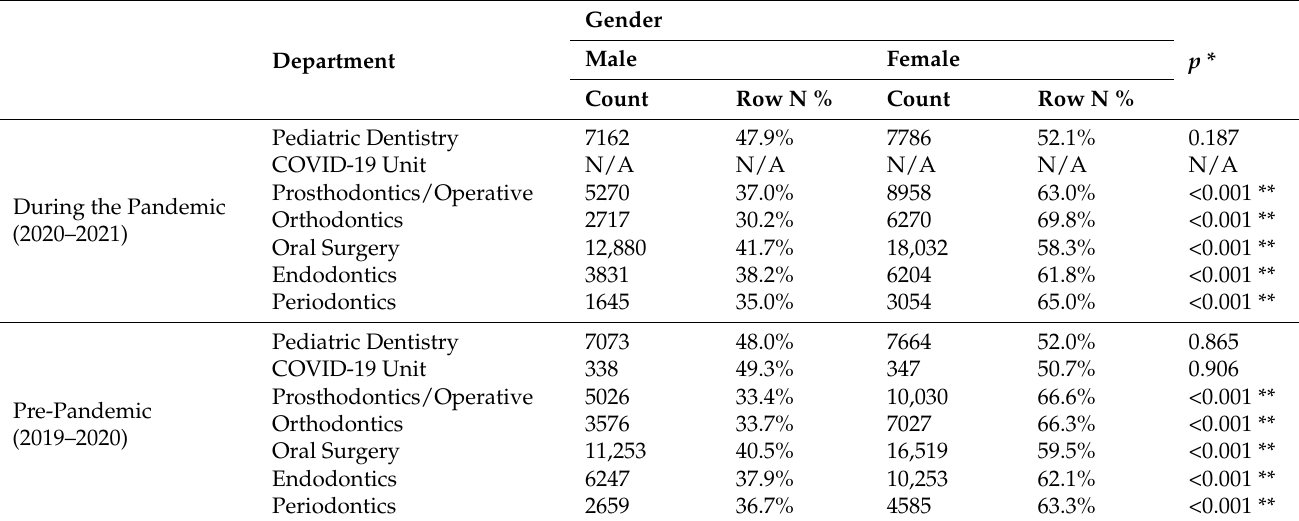
Table 2. Attendance differences according to gender.